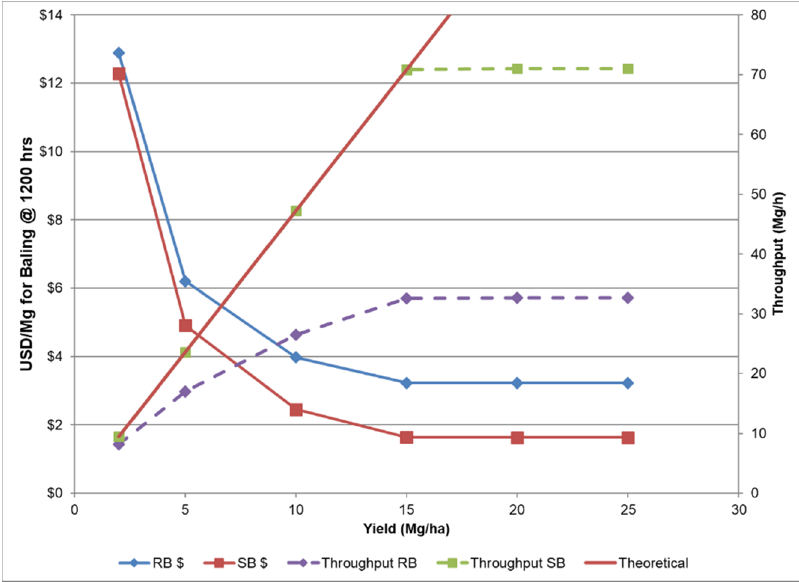
Figure 7. The cost per Mg to operate the square and round balers for annual use of 1200 h. The solid red line is the theoretical capacity of the baler and the dashed line is the baler-achieved throughput after accounting for throughput restrictions.